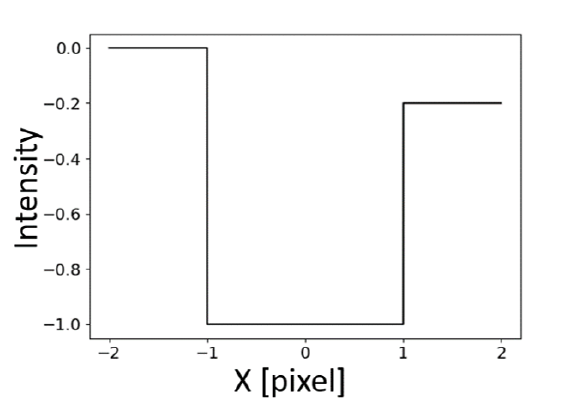
Figure 1. Example of an asymmetrical bar-shaped line profile (dark line over a bright background) of half-width w = 1 pixel, asymmetry a = 0.2 and line contrast h = 1 with respect to the